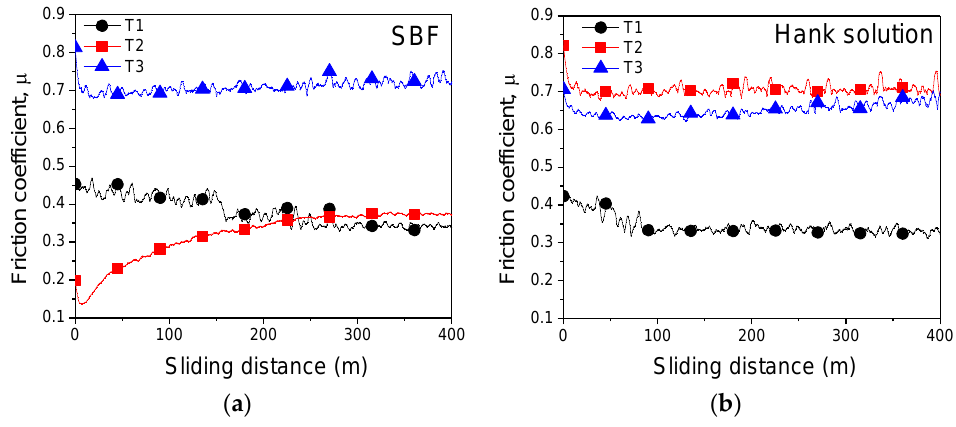
Figure 4. Evolution of the friction coefficients for T1, T2, and T3 alloys vs. sliding distance in ( a ) simulated body fluid (SBF) and ( b ) Hank solution.